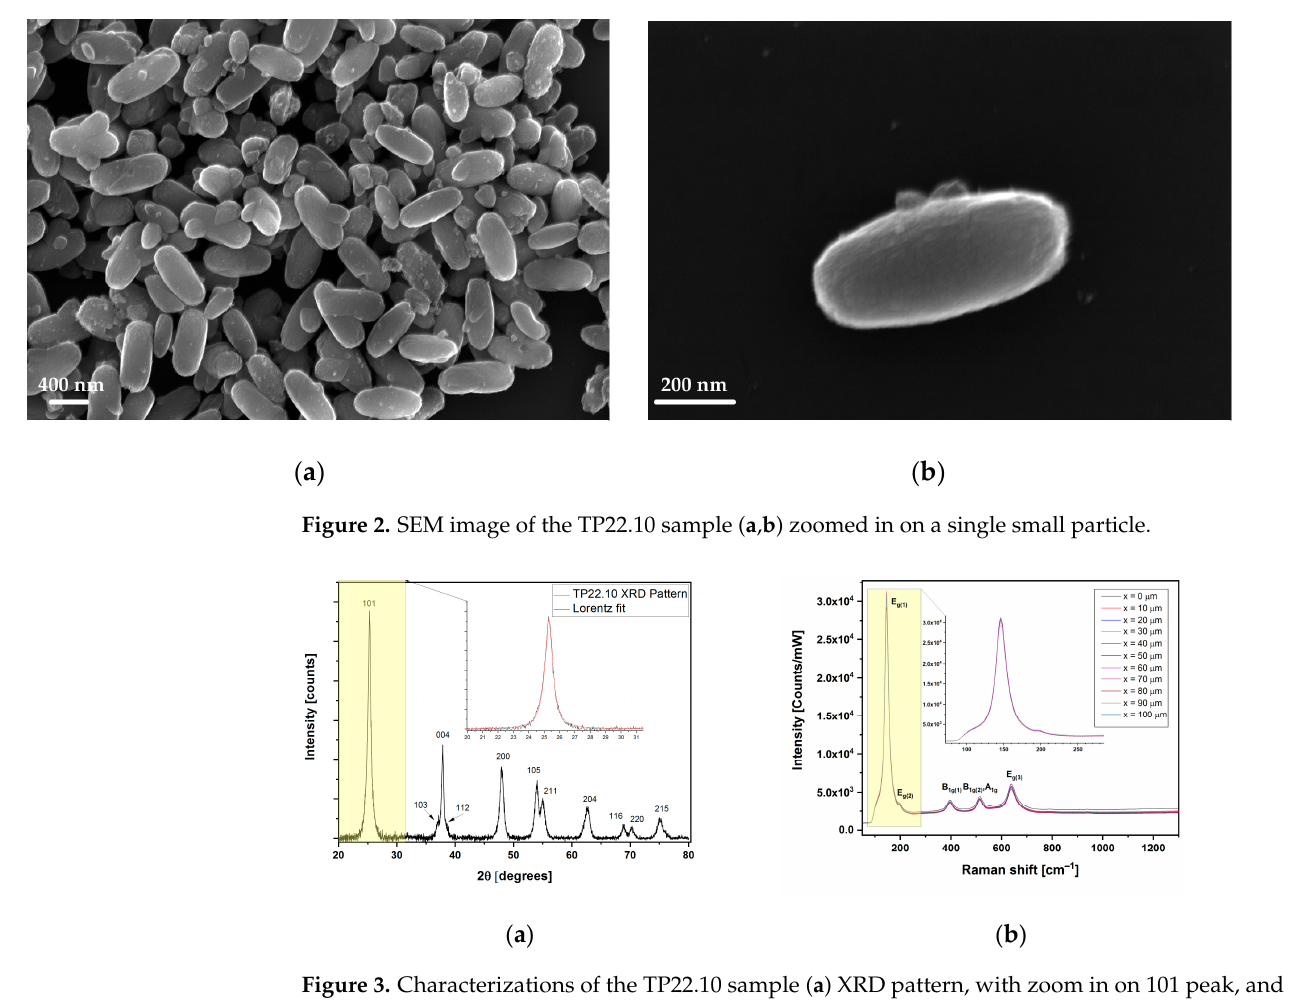
Figure 2. SEM image of the TP22.10 sample ( a , b ) zoomed in on a single small particle.